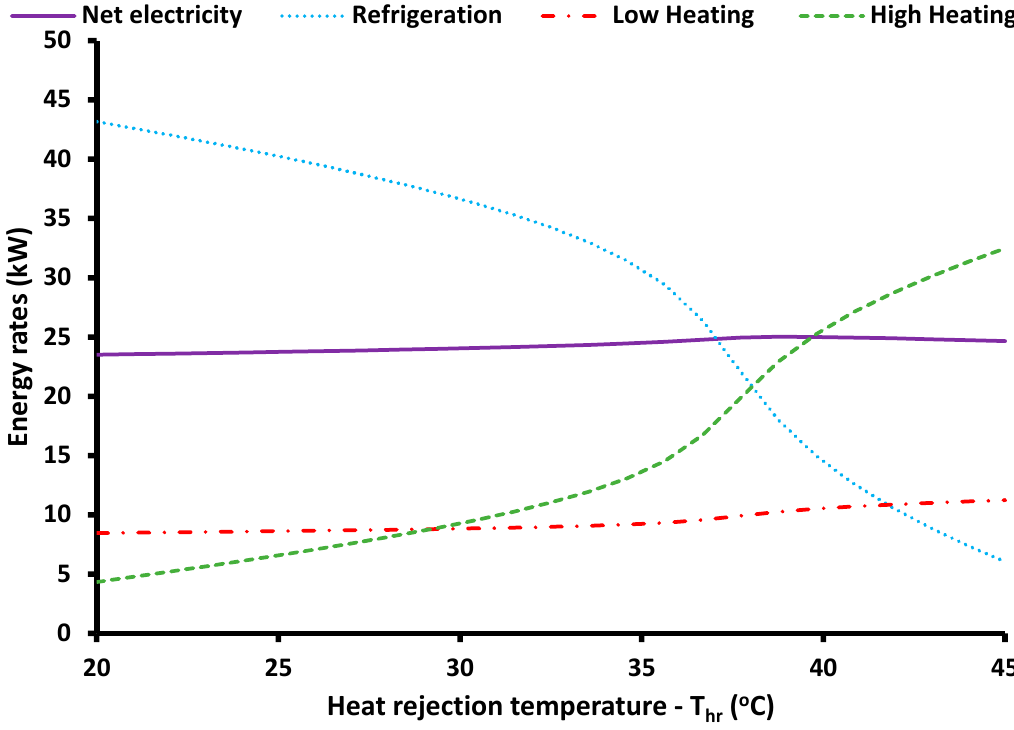
Figure 14. Useful energy products for different values of the heat rejection temperature.